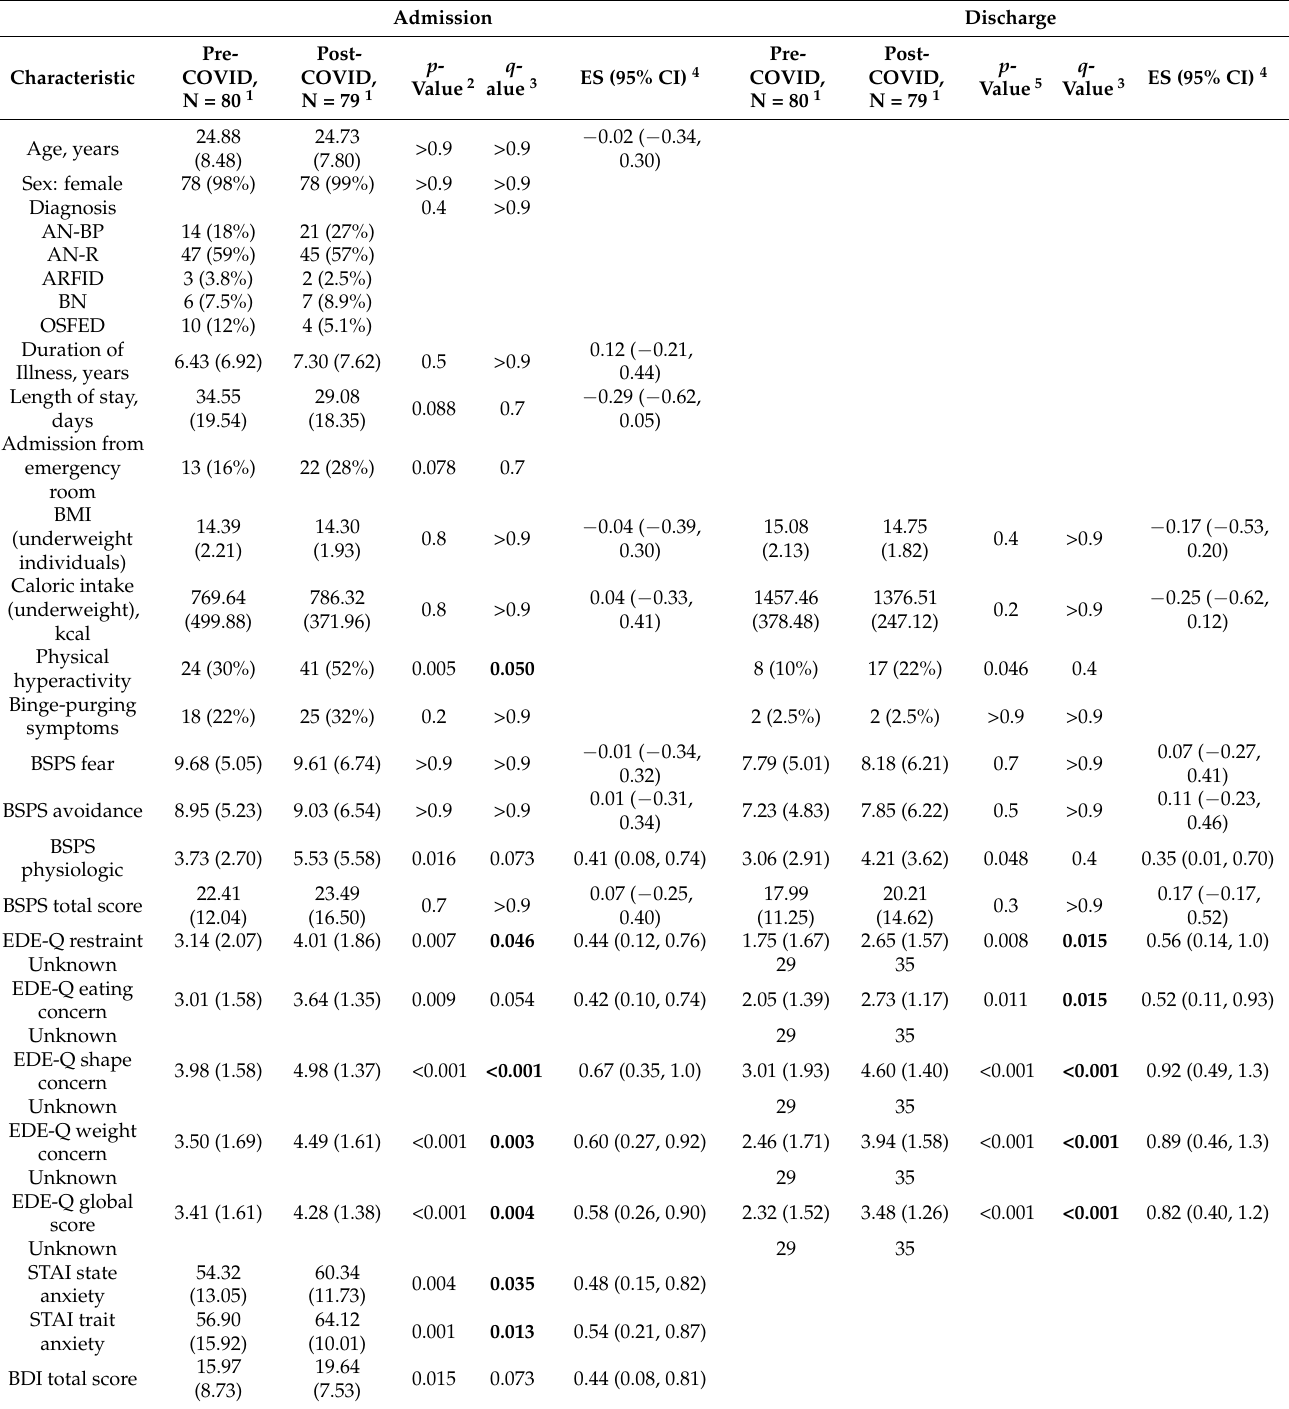
Table 1. Comparison of clinical and psychopathological measures at admission and discharge between individuals hospitalized before and after the start of the COVID-19